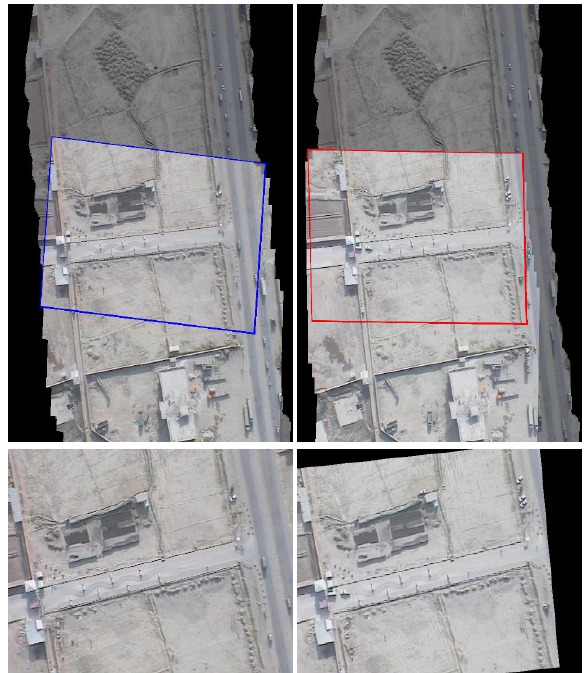
Figure 1: Video mosaics of the example scene access point : Pre- vious overflight with selected frame (blue, left) corresponding to the new frame (red, right) in the current overflight. 2nd row: Cur- rent frame (right) aligned to the previous frame